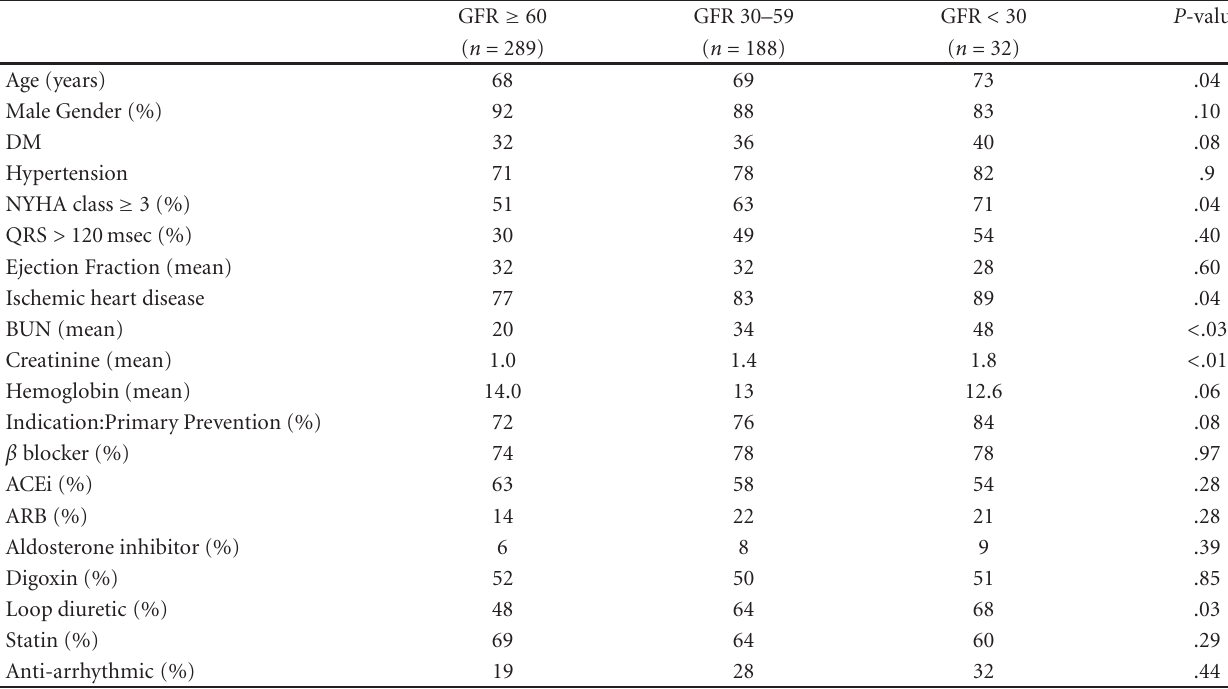
Table 1: Baseline characteristics of the study population.